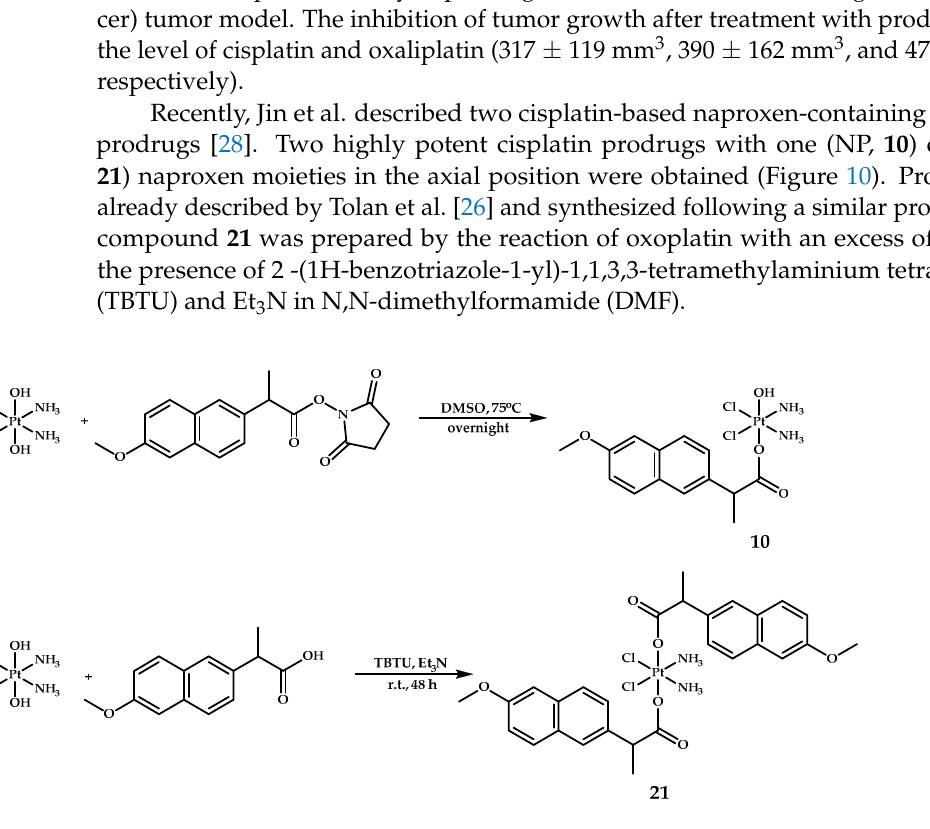
Figure 10. Synthesis of cisplatin-based monocarboxylated platinum(IV) prodrug 10 and dicarboxylated platinum(IV) prodrug 21 with one or two moieties of naproxen in axial positions, respectively.